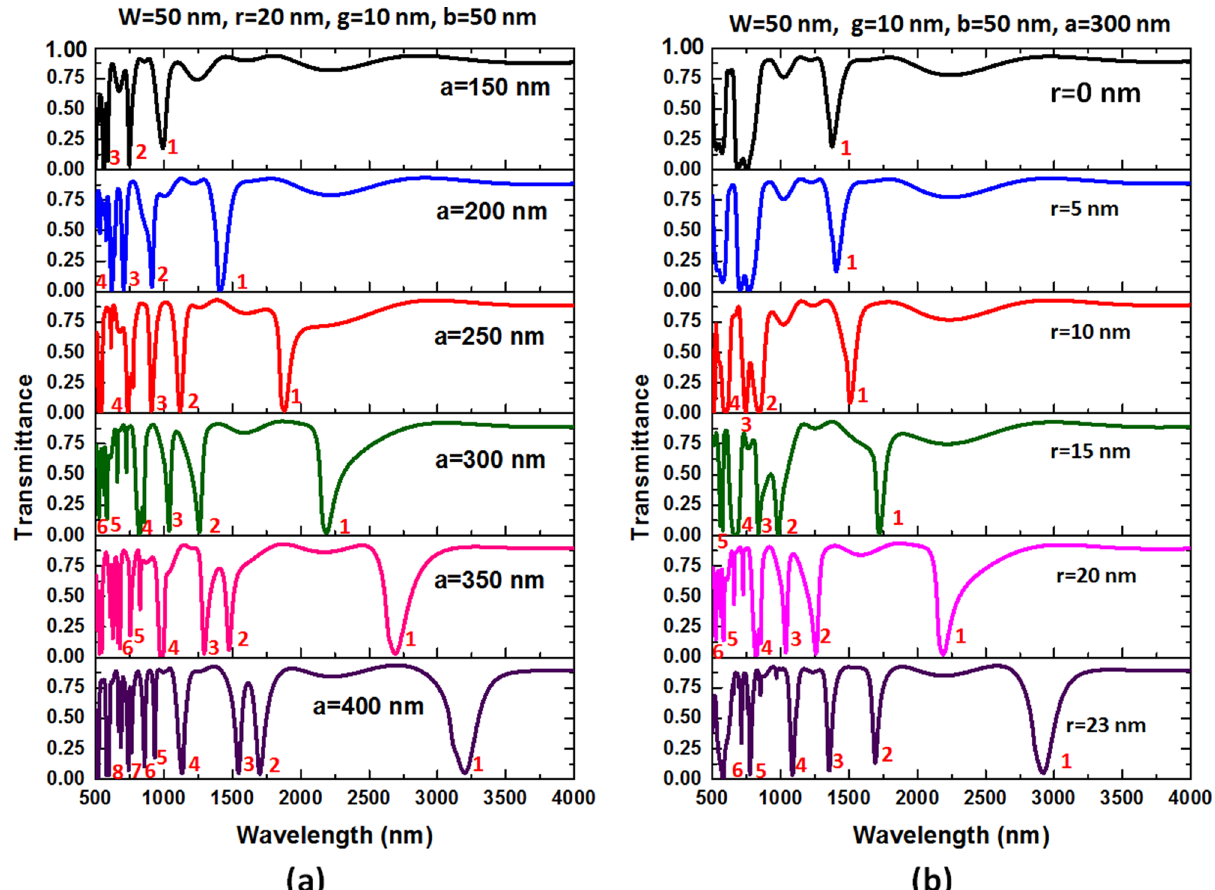
Figure 8. Transmission spectra as a function of ( a ) a variation and ( b ) r variation of the case 2 structure. The mode numbers label in the figures’ inset and the structural parameters are at the top of the